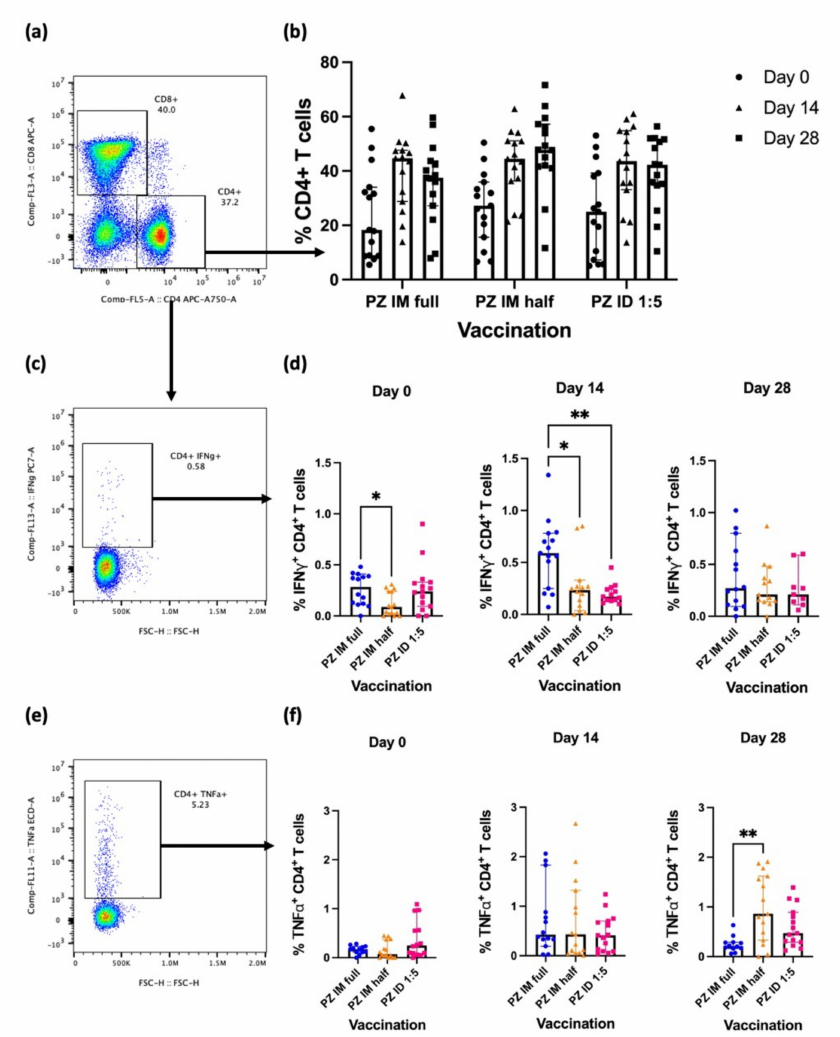
Figure 1. Effector cytokine production of S1-specific CD4 + T-cells after BNT162b2 boosting. All volunteers were previously vaccinated with two doses of inactivated SARS-CoV-2 vaccines (n = 91). The BNT162b2 mRNA booster was administered in three groups: full dose intramuscularly (n = 30), half dose intramuscularly (n = 30), and one-fifth vaccine dose intradermally (n = 31). ( a ) CD4 + and CD8 + T-cell populations, ( b ) percentage of CD4 + T-cells at Day 0 (before booster dose), Day 14, and Day 28 (after booster dose), ( c ) S1-specific IFN- γ -producing CD4 + T-cells, ( d ) percentage of S1-specific IFN- γ -producing CD4 + T-cell responses at Day 0 (before booster dose), Day 14, and Day 28 (after booster dose), ( e ) S1-specific TNF- α -producing CD4 + T-cells, ( f ) Percentage of S1-specific TNF- α pro- ducing CD4 + T-cell responses at Day 0 (before booster dose), Day 14, and Day 28 (after booster dose). Each symbol represents the median of one participant with 95% CI (n = 30–31 volunteers). Statistical significance was determined using the Kruskal–Wallis’s test, with Dunn’s multiple comparison test between vaccinated groups. * p ≤ 0.05; ** p ≤